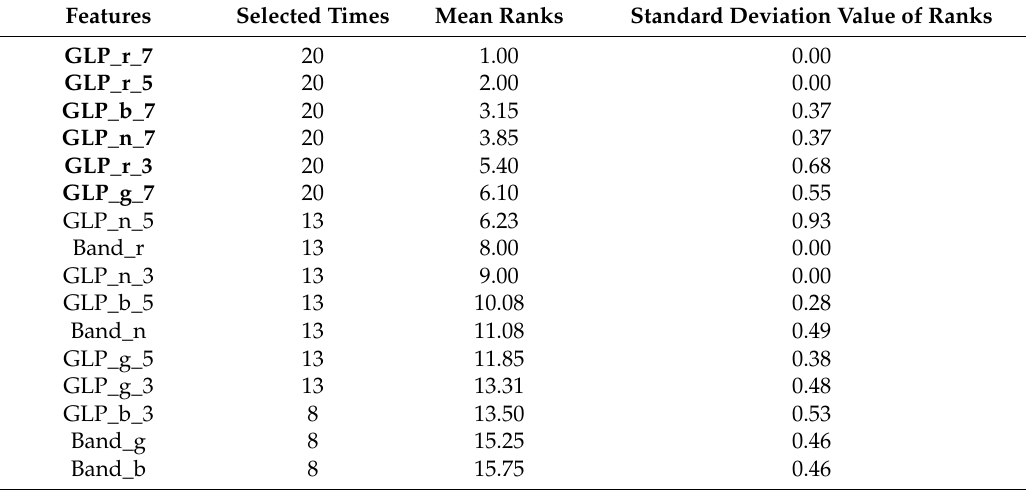
Table 3. Feature selection results for the spectral bands adding the Gaussian low-pass filters (GLP). _b/g/r/n_3/5/7: the filter features derived from the blue, green, red, and near-infrared bands using the kernel sizes 3 × 3, 5 × 5, and 7 × 7 pixels. Band: the spectral band. The bold features were selected as members of the final feature